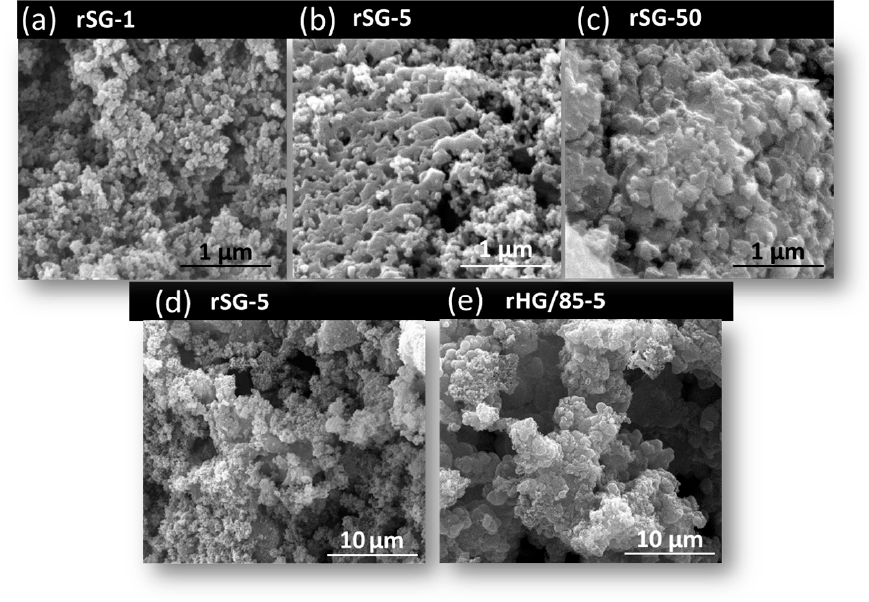
Figure 7. SEM images of reduced silica gels using different heating rates at high magnifications ( a ) rSG-1, ( b ) rSG-5, ( c ) rSG-50, and comparison between silica ( d ) and C-Si hybrid ( e ) gels at low magnifications